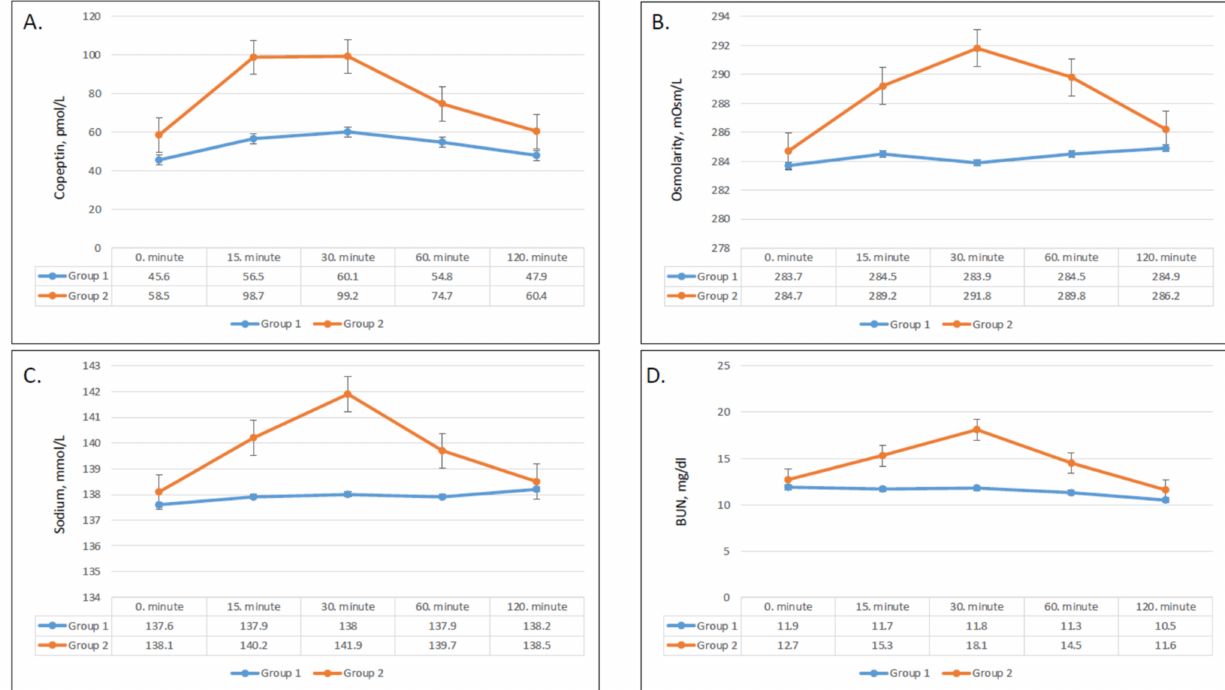
Figure 3. Changes in plasma copeptin ( A ), plasma osmolarity ( B ), sodium ( C ), and BUN (blood urea nitrogen) ( D ) values in group 1 and group